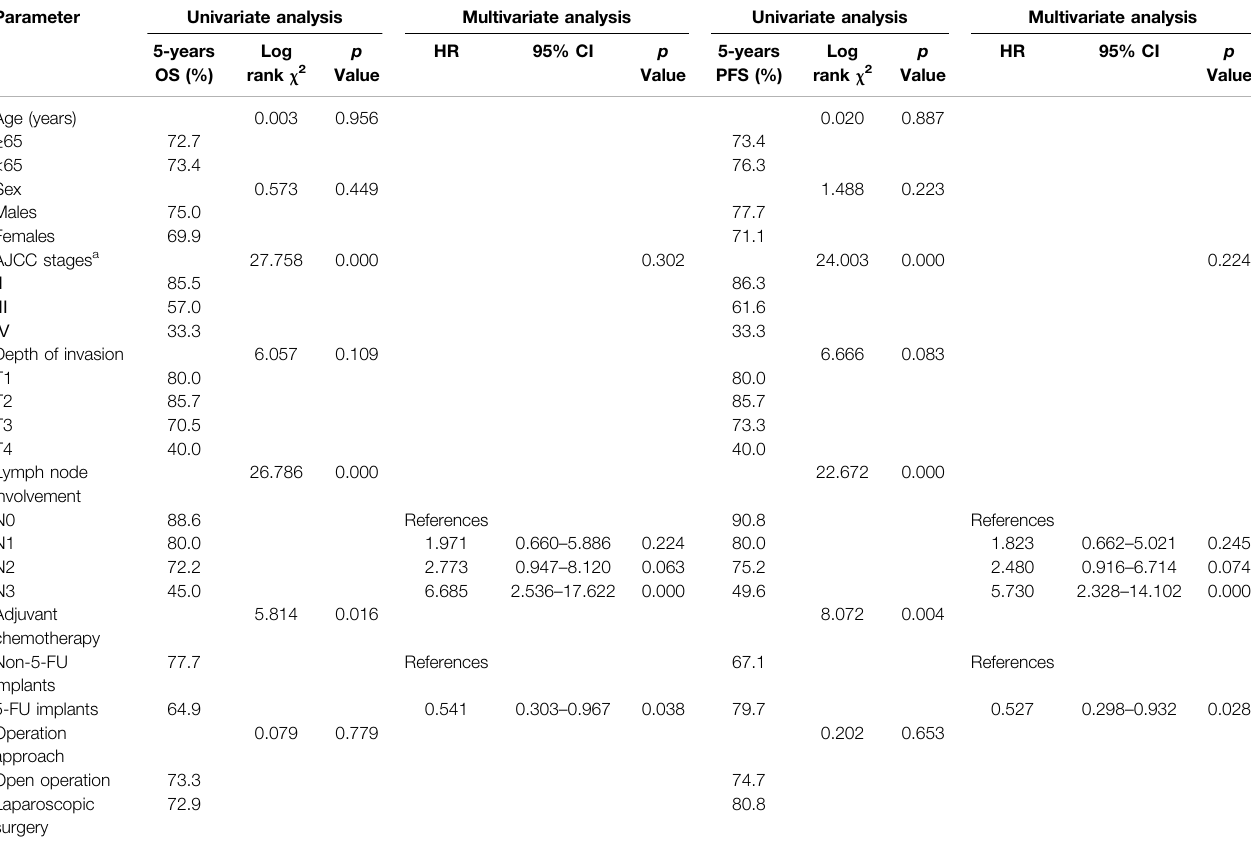
TABLE 5 | Univariate and multivariate survival analysis of overall survival (OS) and Progression-free survival (PFS) predictors. Parameter Univariate analysis Multivariate analysis Univariate analysis Multivariate analysis